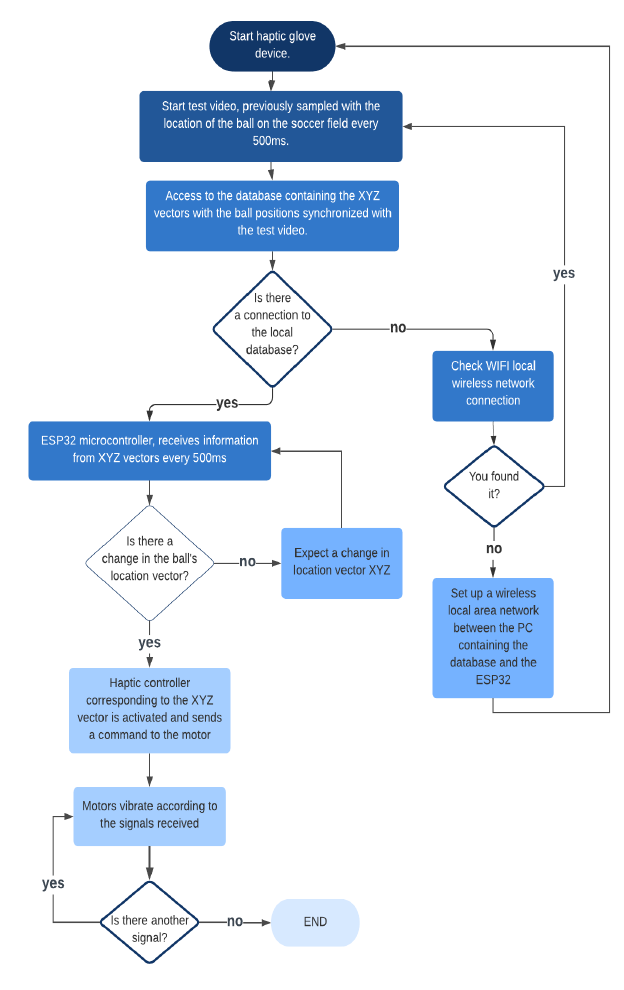
Figure 5. Flowchart of haptic glove